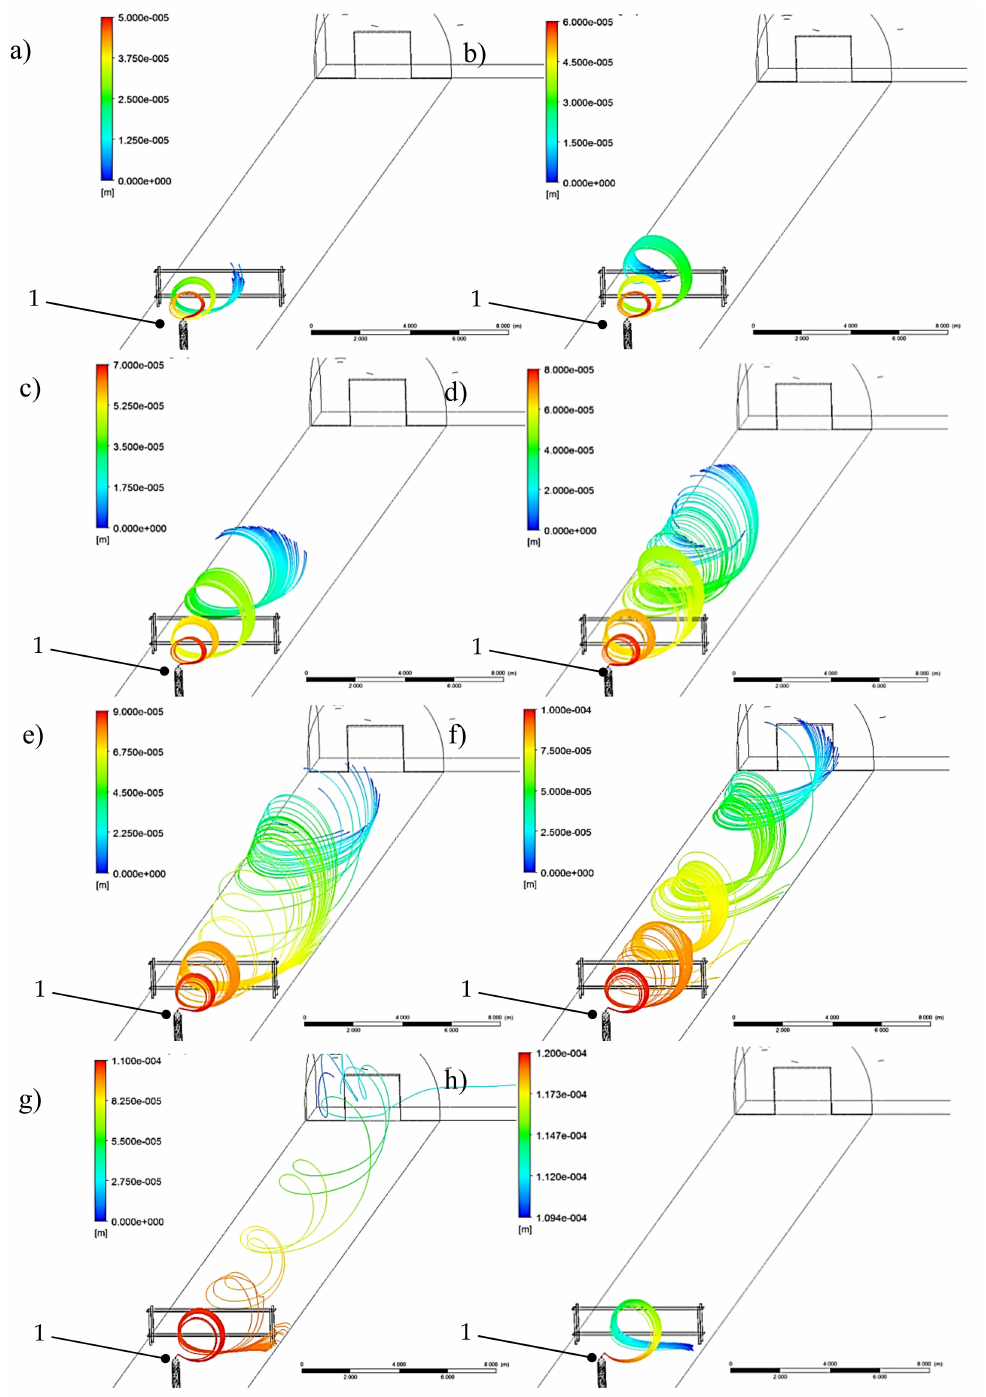
Figure 14. The trajectory of aerosol drops depending on particle size: ( a ) 50 µ m, ( b ) 60 µ m, ( c ) 70 µ m, ( d ) 80 µ m, ( e ) 90 µ m, ( f ) 100 µ m, ( g ) 110 µ m, ( h ) 120 µ m, and 1—nozzle. Figure 15 shows the actual concentration changes of coarse aerosols in the range 2500–19810 nm measured at 1.55 m (Figure 15a) and 0.65 m (Figure 15b) above the floor, respectively. The vertical axis of the graph shows the distribution of changes in the concentration of aerosol droplets. The horizontal axis of the graph measures the distance from the